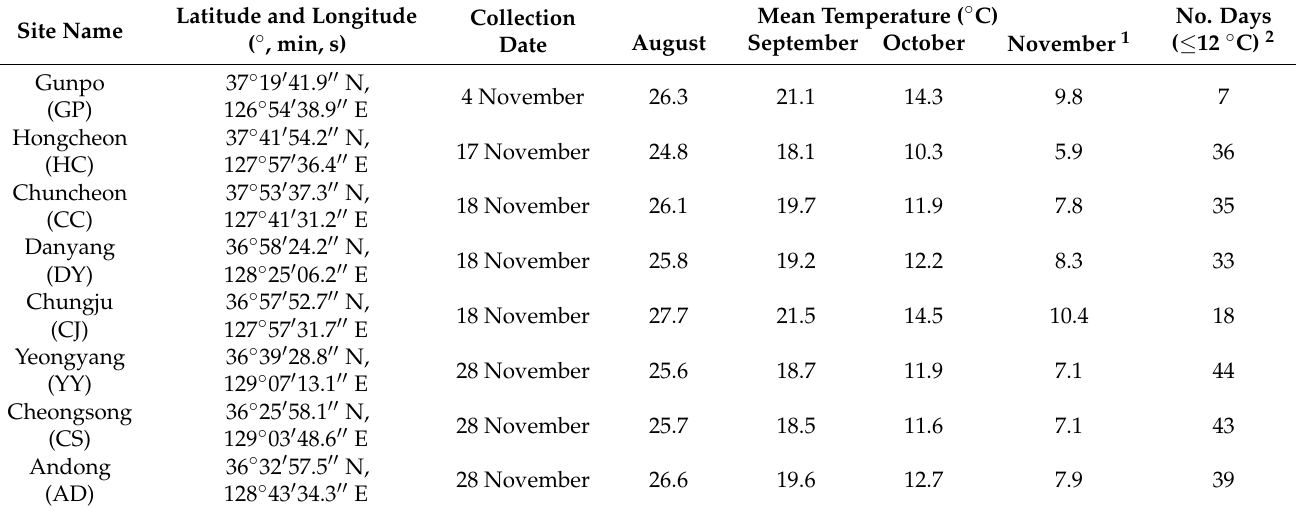
(Table 1). Egg populations collected from Gunpo (GP), Chuncheon (CC), Danyang (DY), and Chungju (CJ) were exposed to experimental temperatures on the sampling dates. Egg samples from Hongcheon (HC), Yeongyang (YY), Cheongsong (CS), and Andong (AD) started treatment at experimental temperatures within three days of the sampling date. These eggs were maintained at 0 ◦ C before experimental treatments. Table 1. Sampling information for the overwintering eggs of Lymantria dispar asiatica .